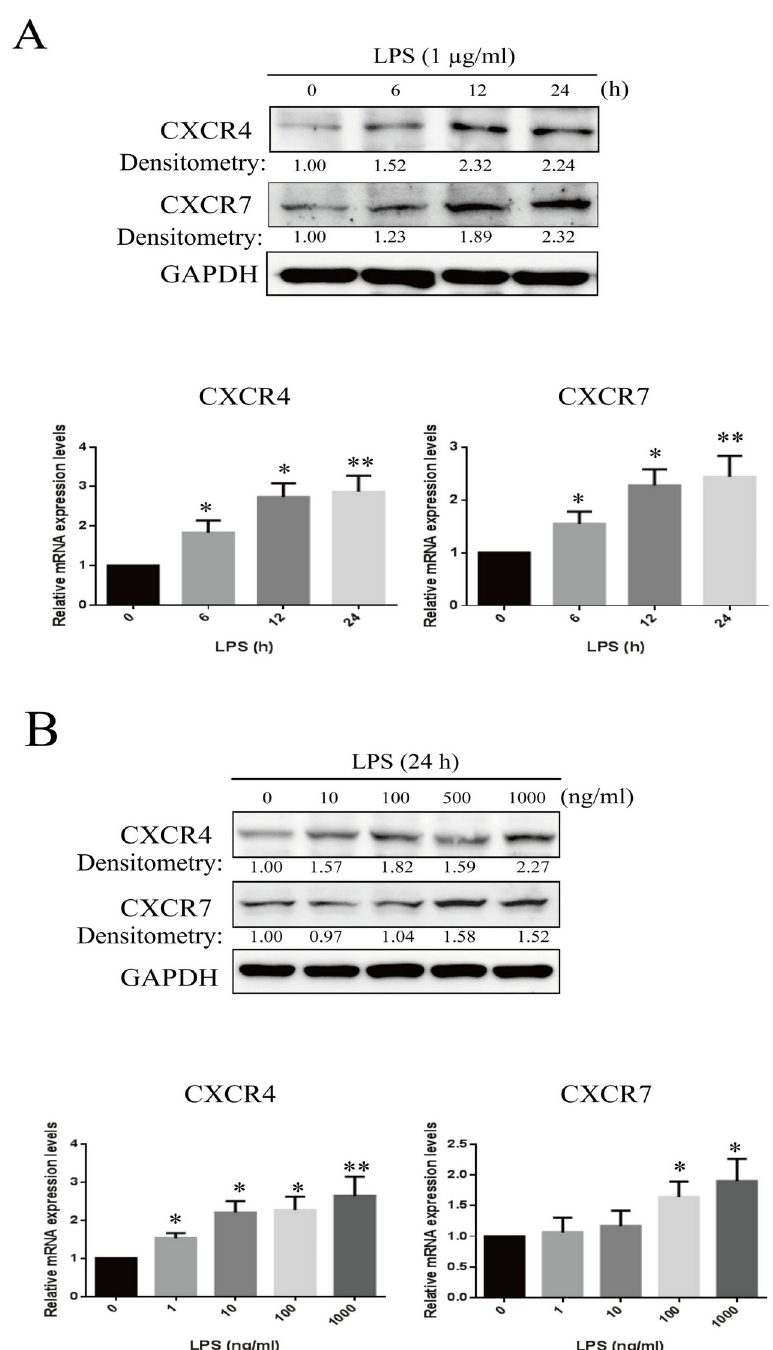
Fig 1. Effects of LPS on CXCR4 and CXCR7 expression in RF/6A cells. Expression levels of CXCR4 and CXCR7 were measured by real-time PCR and western blots. ( A ) The mRNA and protein levels of CXCR4 and CXCR7 in RF/6A cells under LPS exposure (1 μ /ml) at different time points. ( B ) The mRNA and protein levels of CXCR4 and CXCR7 in RF/6A cells under different doses of LPS exposure for 24 h. Data are shown as the mean ± SD of four separate experiments. Statistical significance determined using one-way ANOVA with * P < 0.05, ** P <